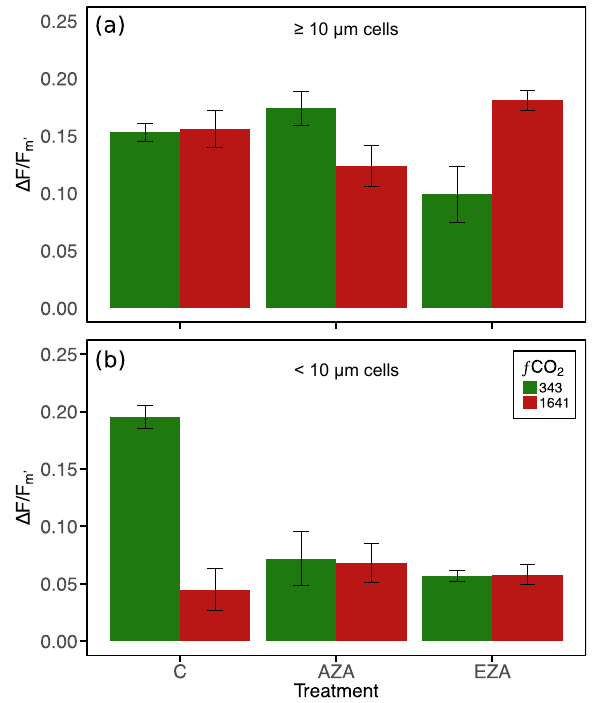
Figure 8. Effective quantum yield of PSII ( (cid:49)F /F m (cid:48) ) of (a) large ( ≥ 10µm) and (b) small ( < 10µm) phytoplankton in the control (343µatm) and high (1641µatm) CO 2 treatments treated with car- bonic anhydrase (CA) inhibitors. A decline in (cid:49)F /F m (cid:48) with the application of inhibitor indicates CCM activity. C denotes the con- trol treatment, which received no CA inhibitor; AZA is the aceta- zolamide treatment, which blocks extracellular carbonic anhydrase; EZA is the ethoxzolamide treatment, which blocks intracellular and extracellular carbonic anhydrase. Error bars display 1 standard de- viation of pseudoreplicate